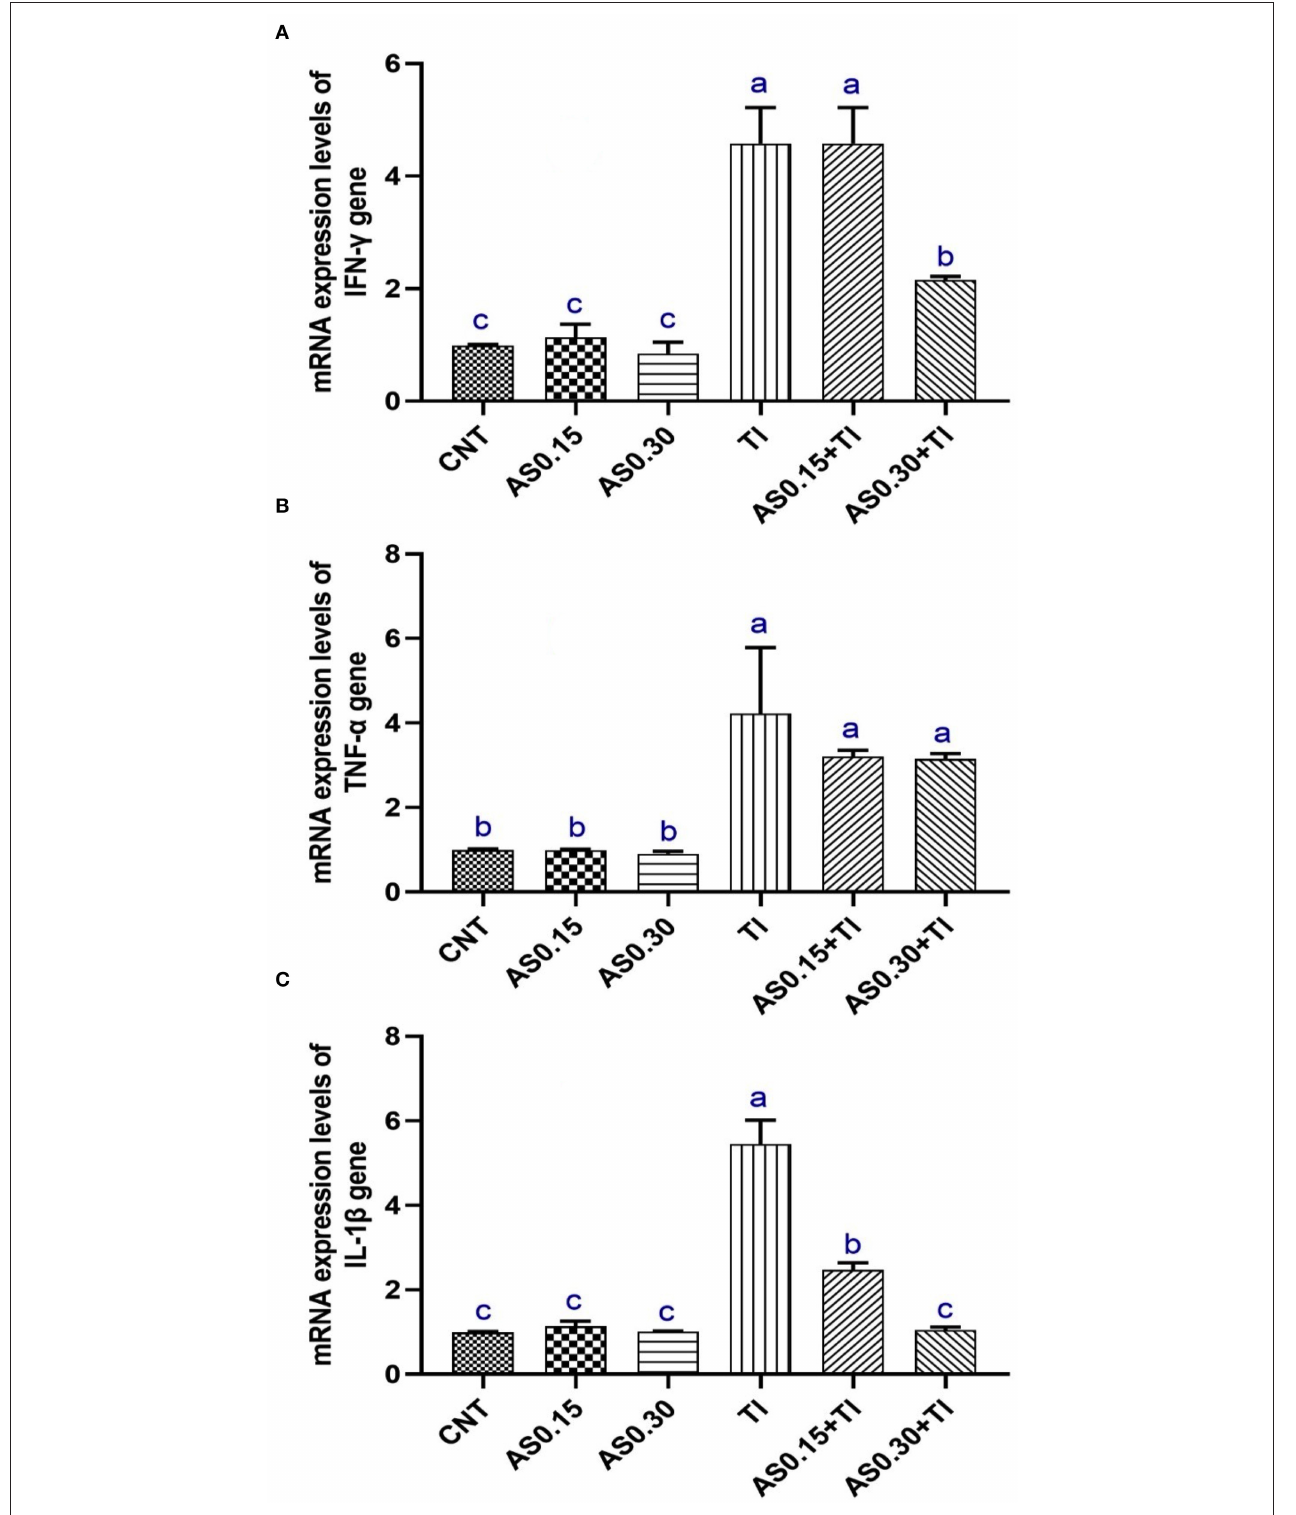
FIGURE 2 | Messenger RNA (mRNA) expression pattern of interferon- γ (INF- γ ) (A) , tumor necrosis factor- α (TNF- α ) (B) , and interleukin-1 β (IL-1 β ) (C) in liver of Nile tilapia fed diets supplemented with Astragalus membranaceus polysaccharides (AS) levels (0.15 and 0.30%) and/or exposed to sub-lethal thallium (Tl) toxicity (1/10th LC50; 41.9 µ g/l) for 8 weeks. Values are mean ± SE and bars not sharing a common superscript letter (a, b, c, and d) differ significantly at P < 0.05.